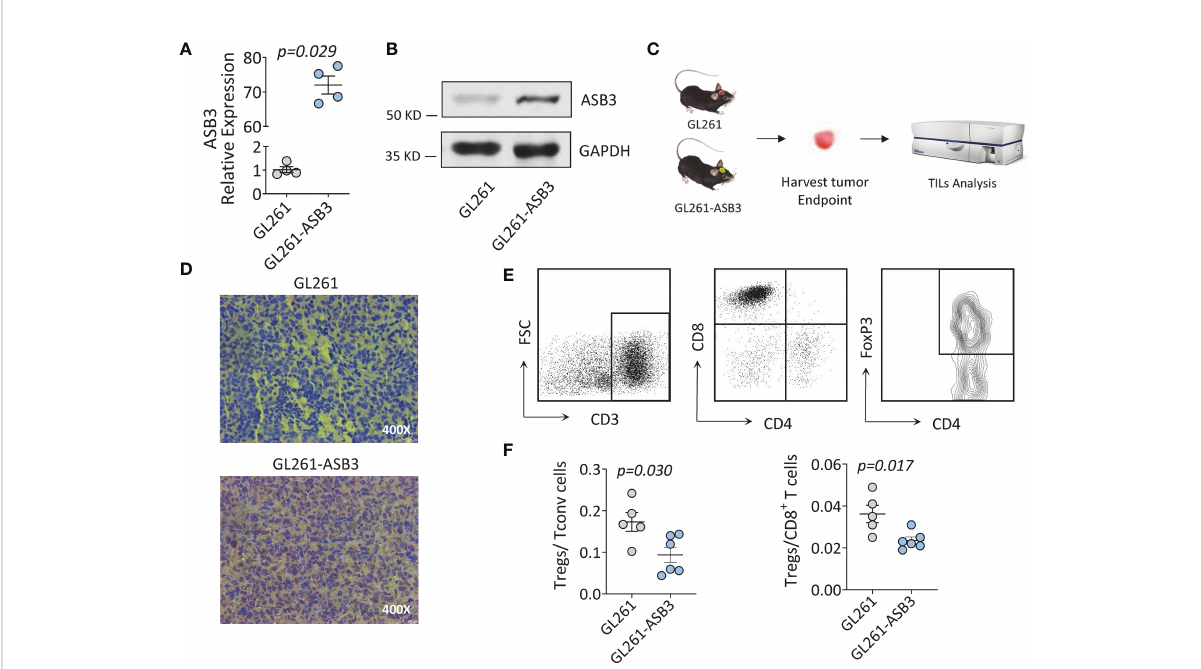
FIGURE 10 The Immunological functions of ASB3 in vivo . (A) ASB3 overexpression veri fi cation at mRNA level in GL261. (B) ASB3 overexpression veri fi cation at protein level in GL261. (C) Flow chart of mice experiments. Harvesting tumor derived TILs at the end of survival period for fl ow cytometry analysis. (D) ASB3 expression was detected by immunohistochemical in mice tumors at the end of survival. (E) Lymphocyte grouping in TILs. Phenotypical analysis was carried out by sequentially gating live cells, CD3 + T cells, CD8 + T cells, CD4 + T cells and FOXP3 + T cells. (F) The ratios of Tregs (CD3 + CD4 + FOXP3 + )/Tconv (CD3 + CD4 + FOXP3 - ) and Tregs (CD3 + CD4 + FOXP3 + )/CD8 + T cells in